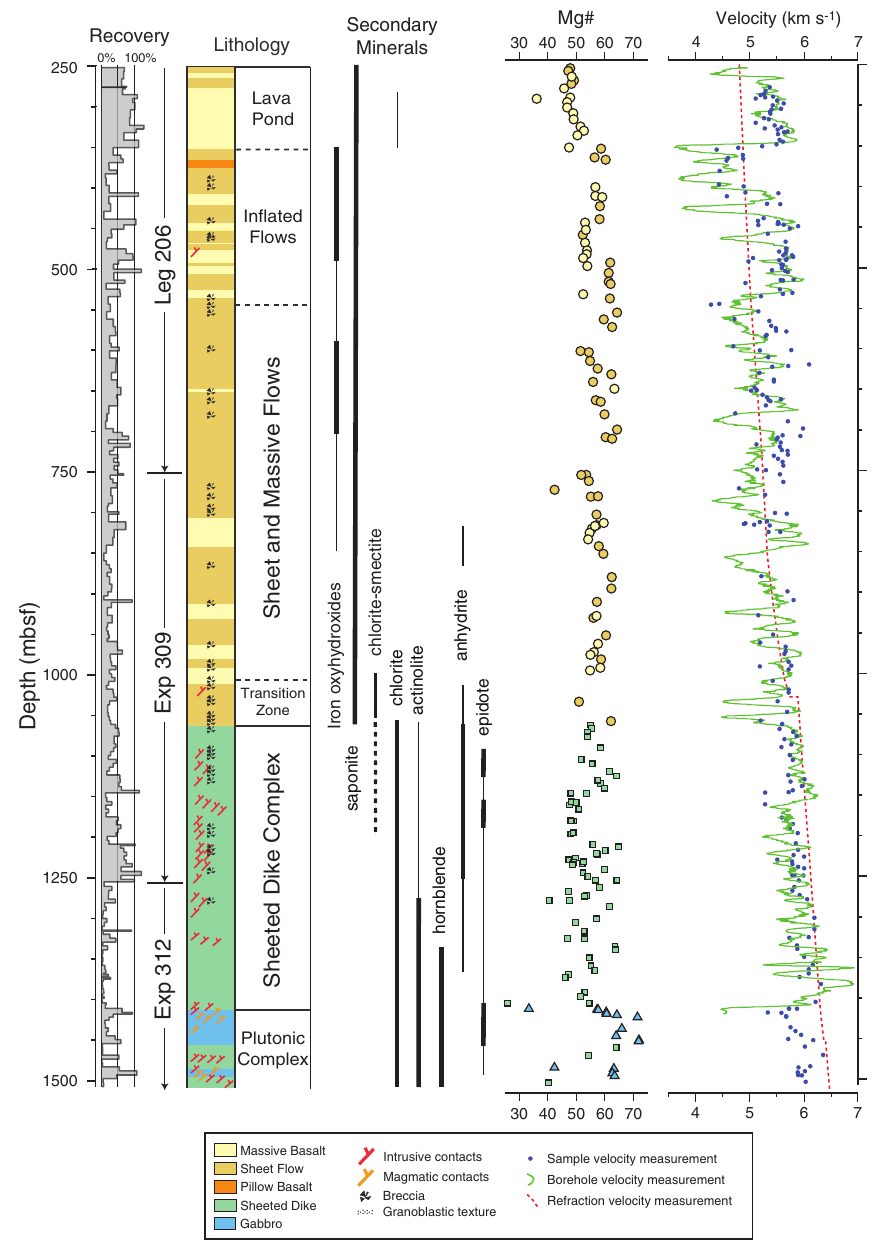
Figure 3. Summary lithostratigraphic column of the basement drilled to date at Site 1256 showing recovery, major lithologies, downcore index alteration, mineral distribution (thick lines = abundant; thin lines = rare), downcore distribution of Mg-number (where Mg# = 100 ° - Mg/ (Mg + (0.9 x Fe) ) atomic ratio), and seismic velocity measured on discrete samples, wireline tools, and seismic refraction (from Wilson et al.,